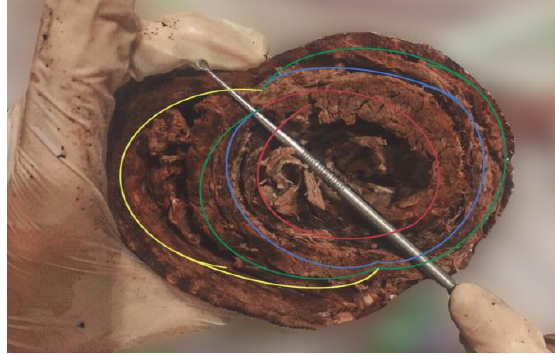
Figure 12. VMS-layers in cow heart. Showing subendocardial layer in red color, mesocardial layer in blue color, proximal part of subepicardial layer in green color and distal part of subepicardial layer in yellow color. of left ventricle and right ventricle part (green circle) the part that form the single-layer wall of right ventricle (Figure